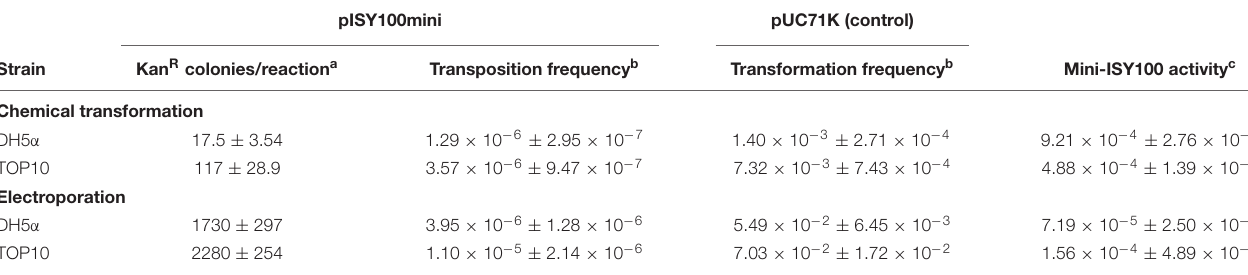
a Number of Kan R colonies obtained from a single reaction. b Number of colonies on LB/Kan divided by the number of colonies on LB. c Transposition frequency divided by transformation frequency.